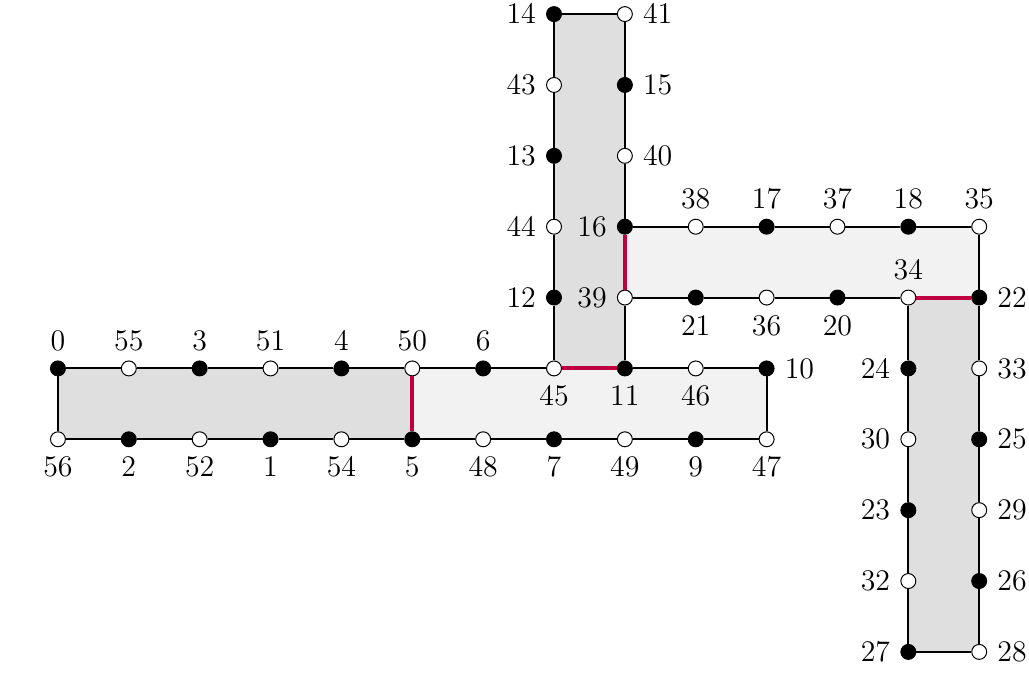
Figure 5: An α -labeling of a member of G